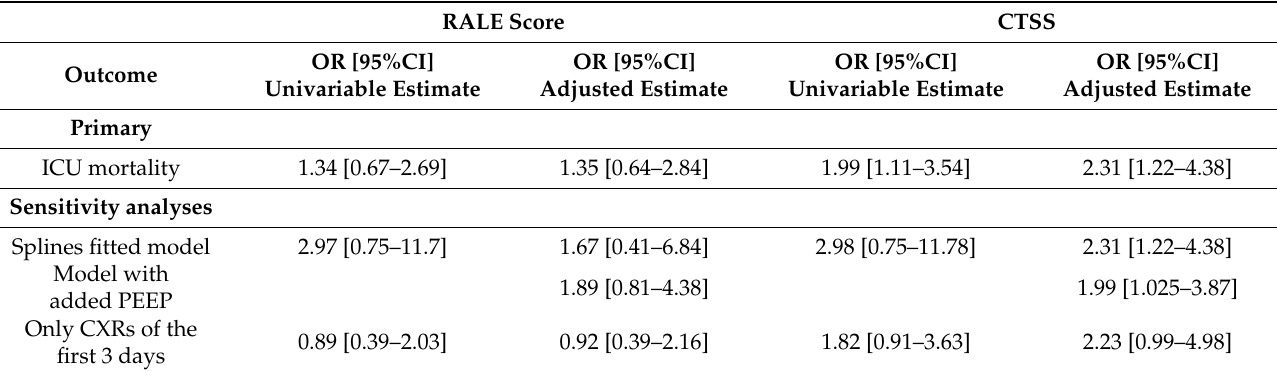
Table 3. Association between imaging scores and